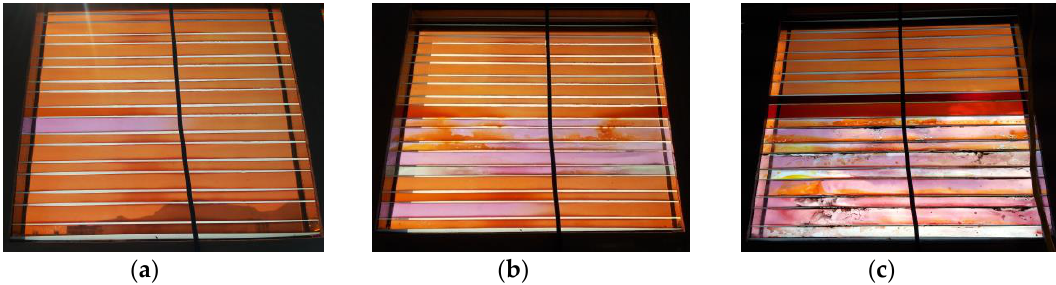
Figure 27. Degradation of the DSSC cells: ( a ) April–May, before the measures here provided, ( b ) during July, and ( c ) after the test in September–October.